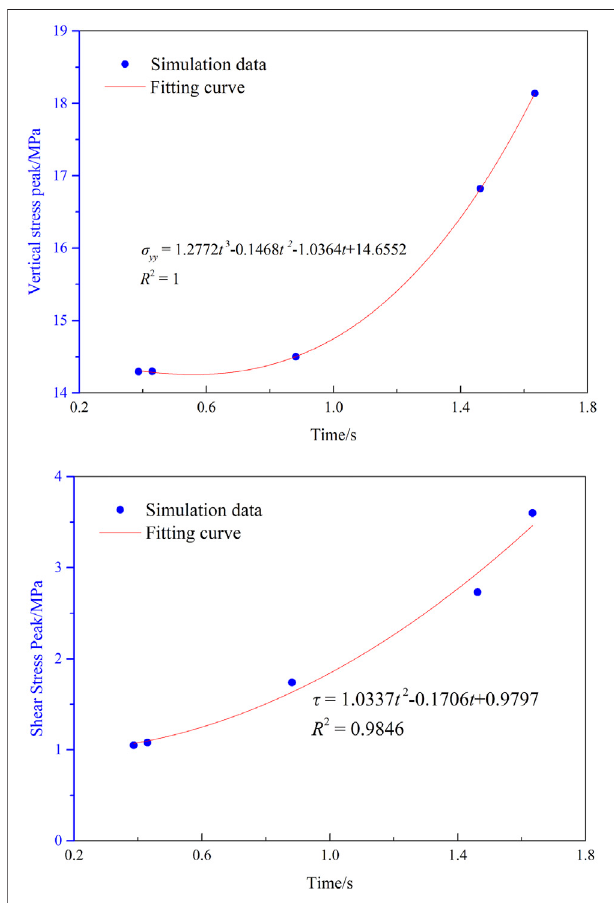
FIGURE 8 | The stress peaks of natural fracture during hydraulic fracturing. (A) Vertical stress peak; (B) shear stress peak.